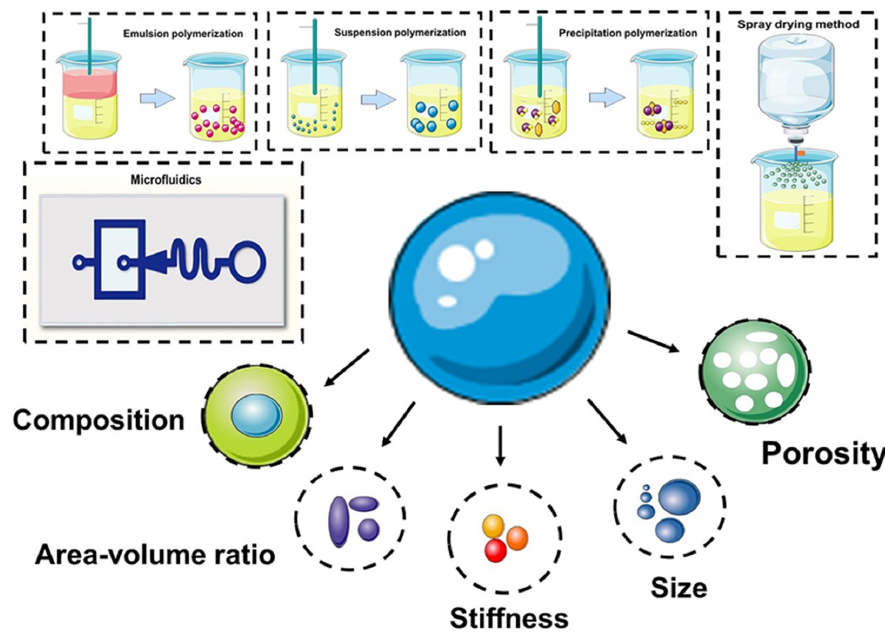
Figure 1. Preparation of microspheres and (bio)chemical/physical features as modulating moieties of microspheres. of